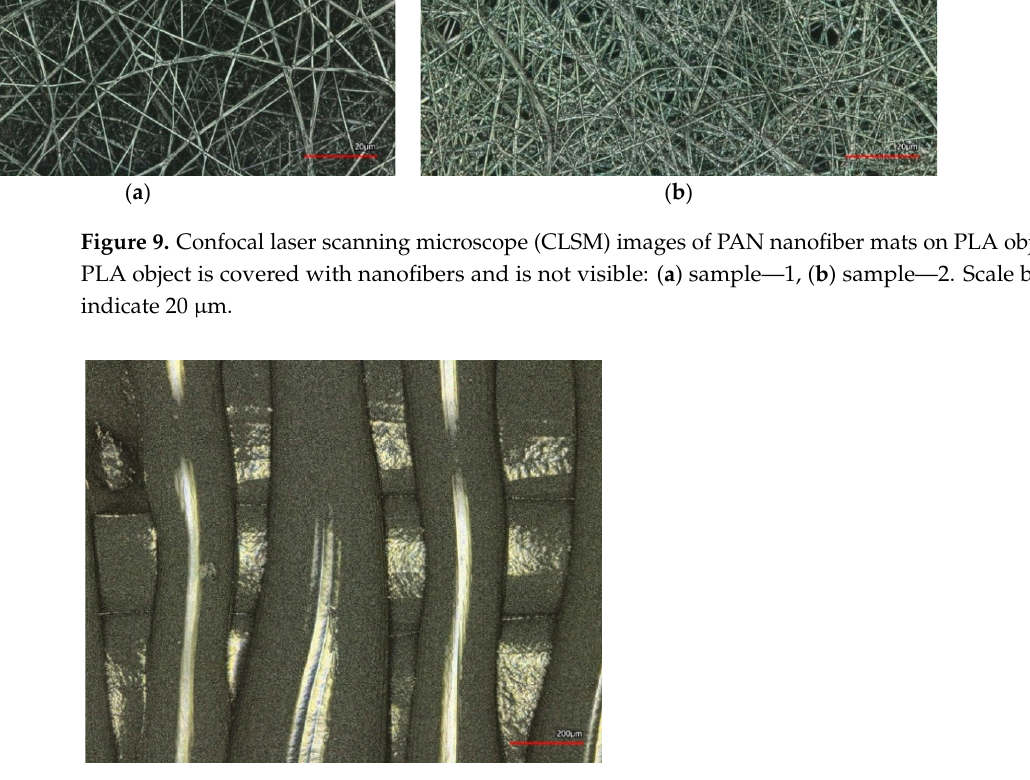
Figure 11. Confocal Laser Scanning Microscope (CLSM) images of of PAN/gelatin nanofiber mats on PLA object. PLA object is covered with nanofibers and is not visible: ( a ) sample—7, ( b ) sample—8. Scale bars indicate 20 μ m.